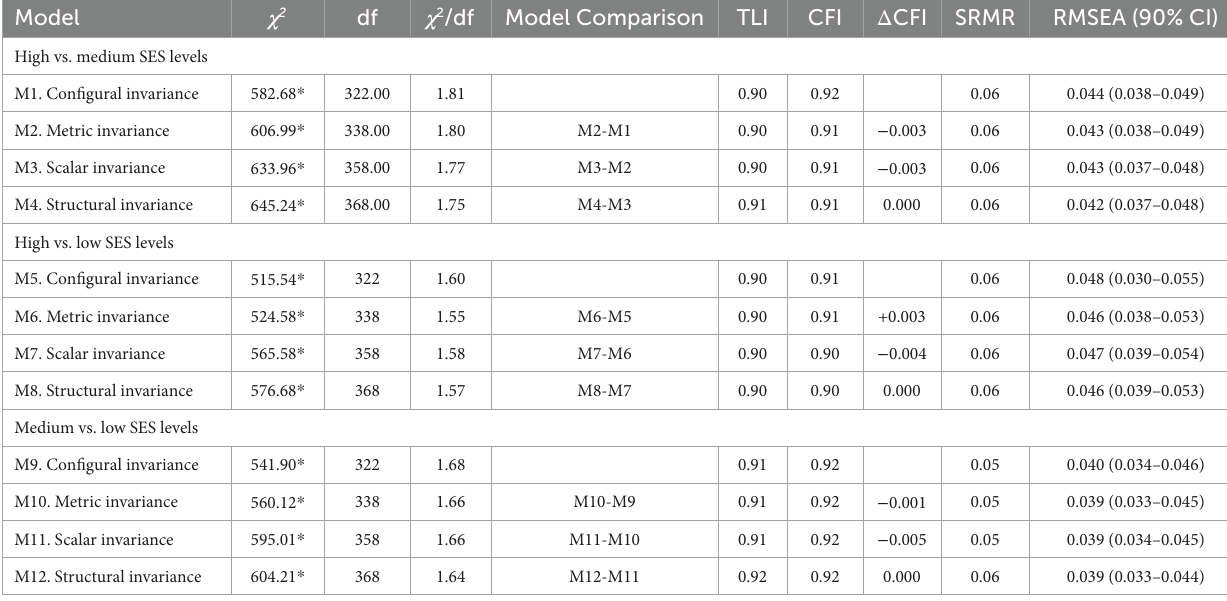
TABLE 4 Testing for Factorial Invariance of ARS_MCV across SES Levels ( n = 569). Model χ 2 df χ 2 /df Model Comparison TLI CFI SRMR RMSEA (90% CI)